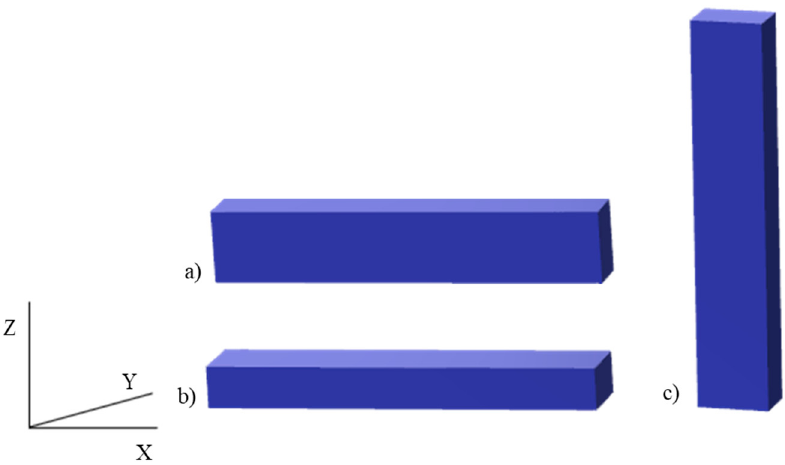
Figure 1. Samples obtained by injection molding or 3D printing.